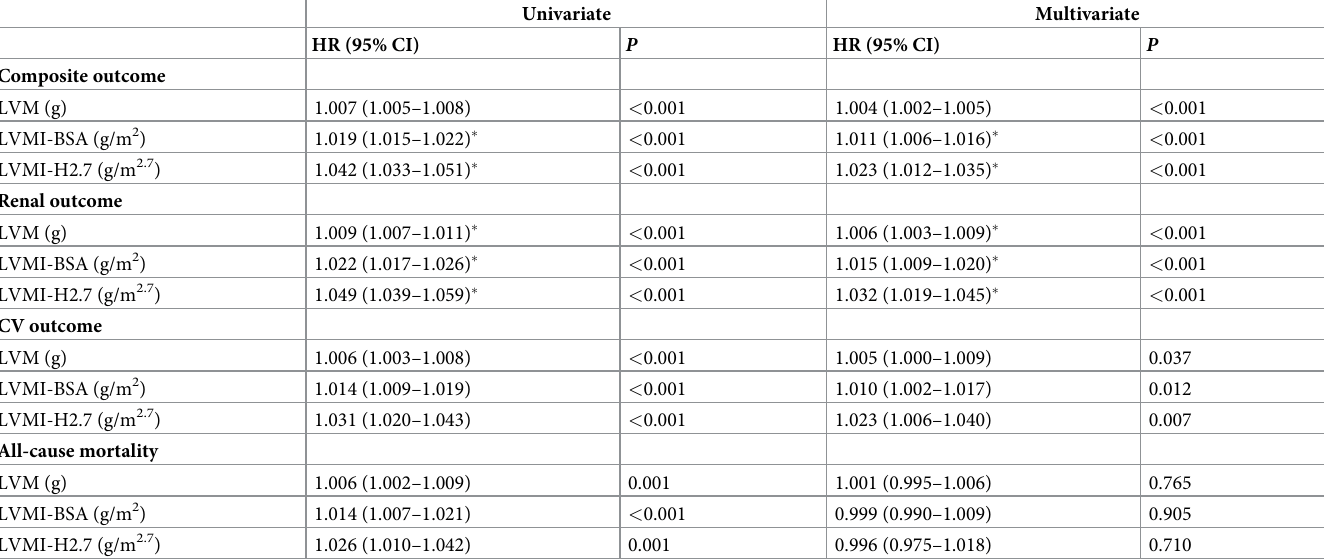
Table 3. Hazard ratios of left ventricular mass and its several indexations for adverse clinical